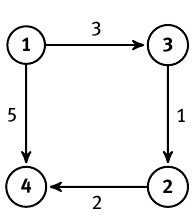
Figure 1: The digraph associated to the matrix W